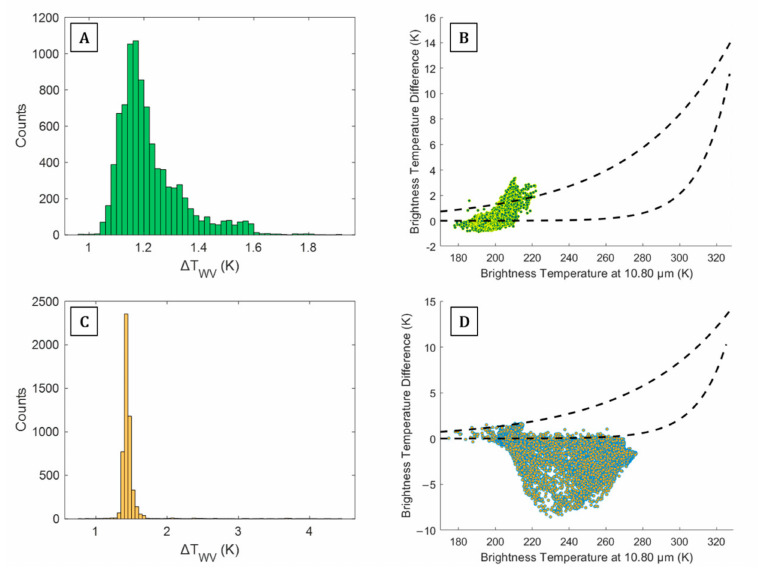
Figure A1. The water vapour correction plots for TIR observations. Images ( A , B ) refer to the Kelud eruption on 13th February 2014 at 17:28 UTC; images ( C , D ) refer to the Calbuco eruption on 23 April 2015 at 05:09 UTC event. The images A and C show the count corrections, whereas the images B and D show the lower and upper water vapour limit curves, as expressed in [26,30], where the points represent all the pixels associated with the volcanic clouds. The water vapour correction is applied for all the points that lie inside the two curves. The water vapour correction allows to detect, by using the BTD , 8982 more ash pixels for the Kelud near-source cloud (i.e. 30.57% more of the area) and of 5104 more pixels for the Calbuco near-source cloud (i.e. 33.72% more of the